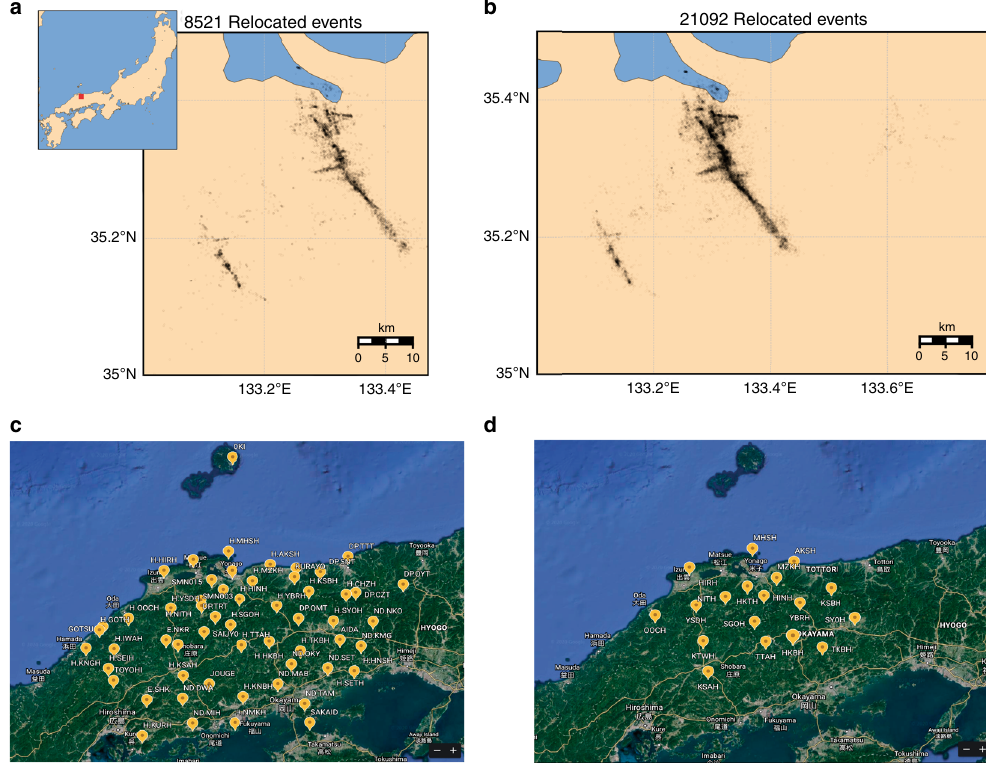
Fig. 5 Tottori Earthquakes. Seismicity of Tottori region between 6 October and 17 November 2000. a relocated events in Fukuyama et al. 22 using manual phase picks by JMA. b relocated events using the automatic phase picker (EQTransformer) of this study. c Distribution of 57 seismic stations used by JMA and Fukuyama et al. 22 d distribution of 18 stations used in our study to detect and locate earthquakes in Tottori